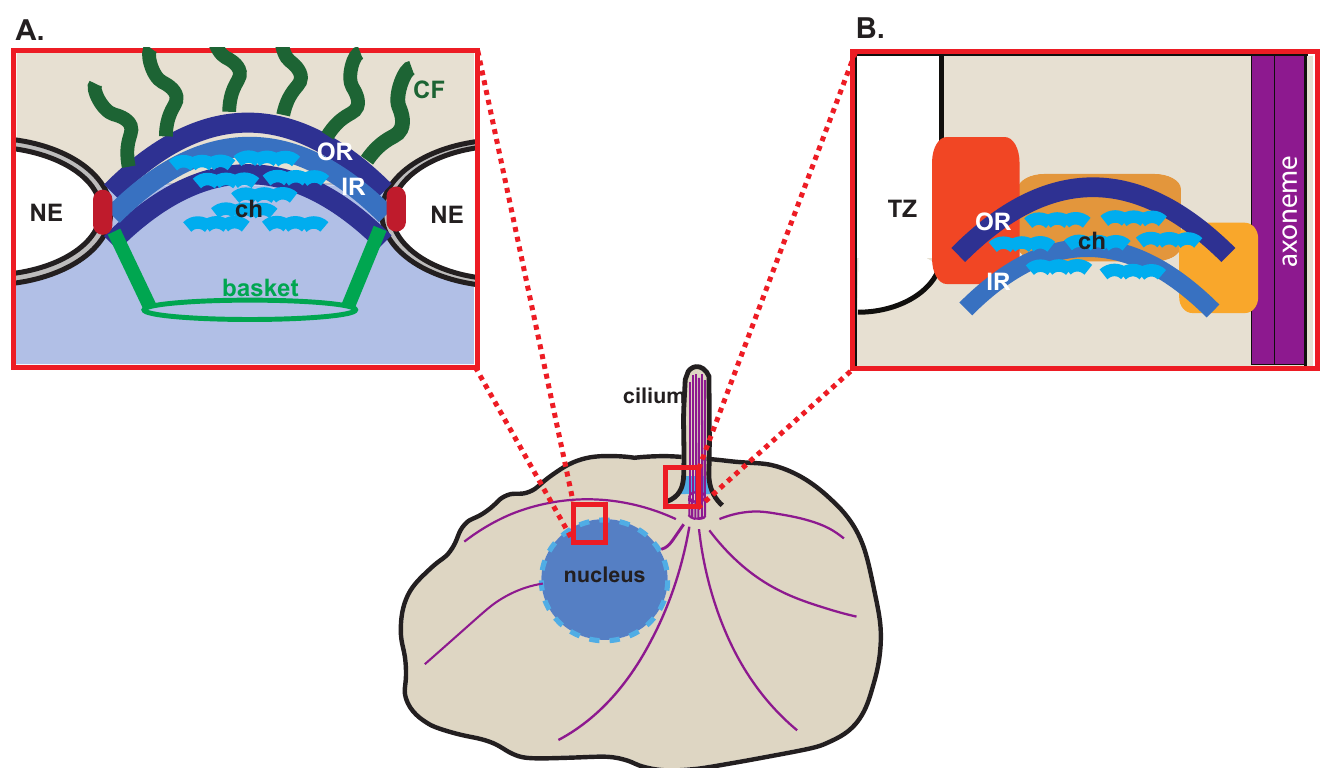
Fig 1. Schematic of nuclear and ciliary gating complexes. (A) At the nuclear envelope (NE), nucleoporins in NPCs are organized into subcomplexes including outer ring (OR, dark blue), inner ring (IR, medium blue), central channel (ch, light blue), cytoplasmic filaments (CF, dark green), nuclear basket (green), and transmembrane (red). (B) At the base of the primary cilium, OR, IR and channel nucleoporins localize at the transition zone (TZ) with NPHP proteins (orange). Purple lines indicate microtubules.